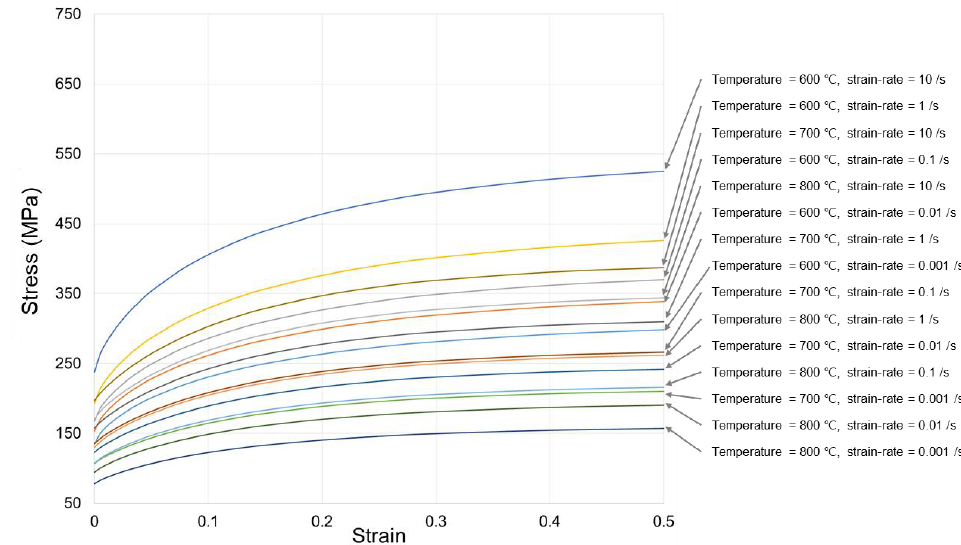
Figure 9. Stress – strain curve of 22MnB5 material used for hot stamping forming analysis. Figure 9. Stress–strain curve of 22MnB5 material used for hot stamping forming analysis. n m m K      (1)